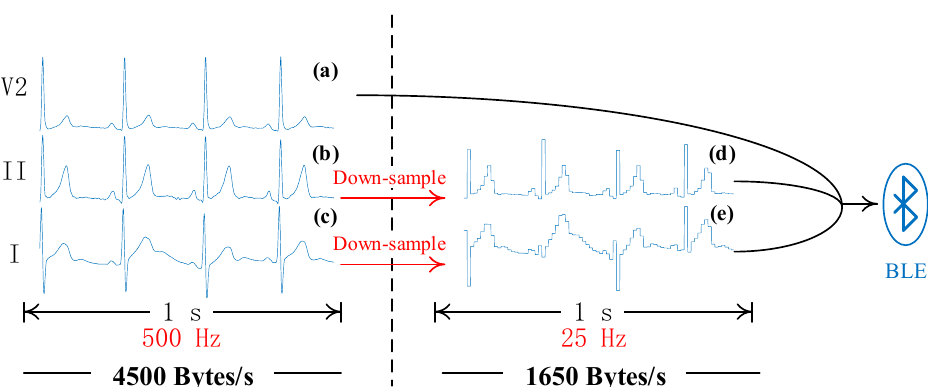
Figure 2. A schematic diagram of the down-sampling operation. ( a – c ) are original signals of leads I, II, and V2, respectively. ( d , e ) are compressed signals. In this example, the 500 Hz signals are resampled to 25 Hz ones. BLE is the abbreviation of Bluetooth Low Energy.